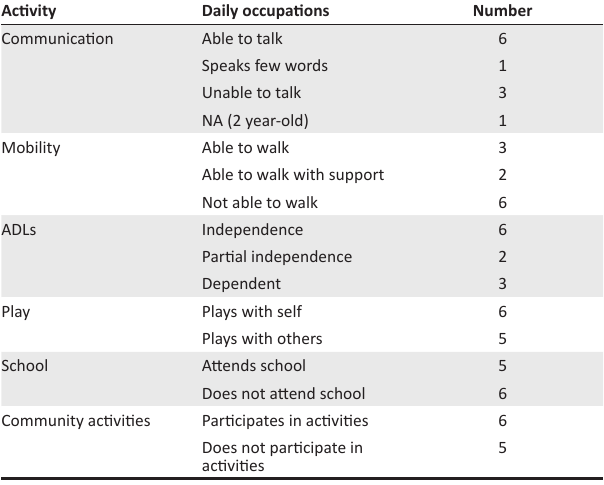
TABLE 1c : Demographics of the children with disabilities.